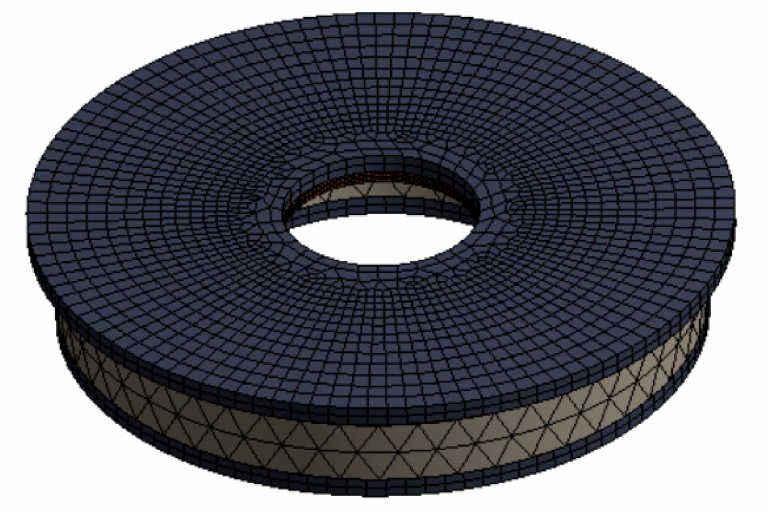
Figure 7. Mesh in 3D of the FEM